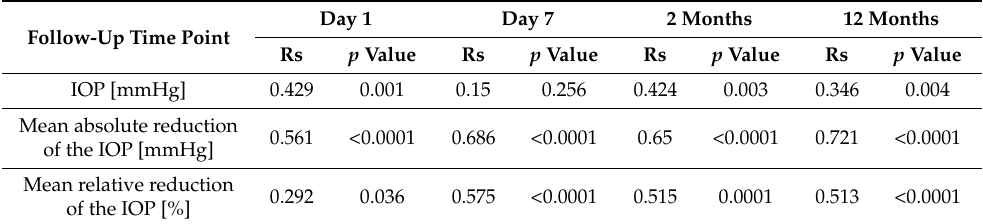
Table 4. Correlations between the baseline intraocular pressure and selected parameters in eyes after endoscopic